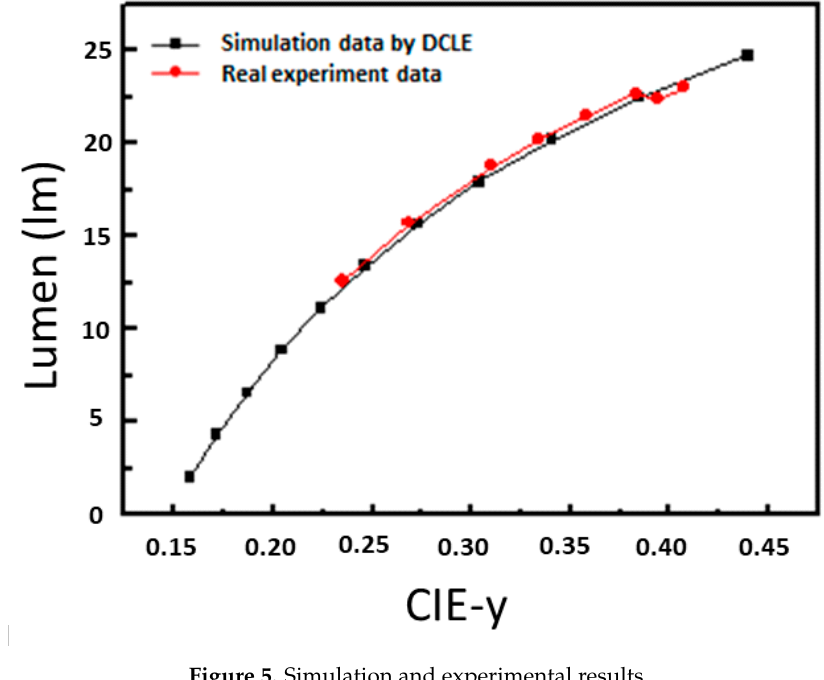
Figure 5. Simulation and experimental results.